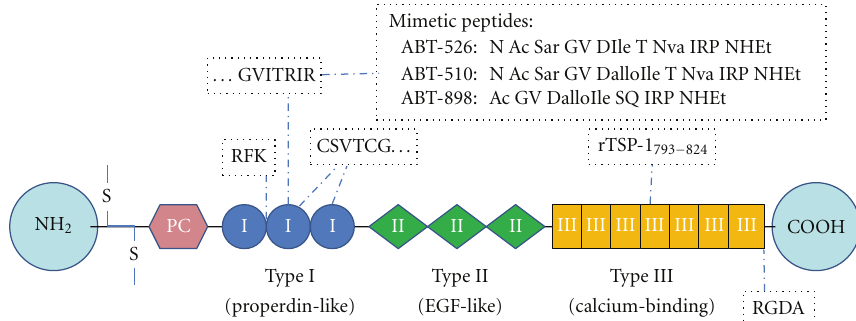
Figure 1: Schematic representation of the structure of TSP-1 and its receptor sites. TSP-1 is a large, homotrimeric molecule (420kDa). Each monomer consists of an interchain disulfide bond (S = S), procollagen homology domain (PC), Type I, II, and III repeats. The amino and carboxyl terminals are globular [8]. RFK and RGDA are the binding sites for TGF β and the integrins, respectively. CSVTCG is the receptor site for CD36. The C-terminal domain of TSP-1 binds CD47. TSP-1 mimetic peptides have been designed from the heptapeptide GVITRIR of the second type-1 repeat. ABT-526 and ABT-510 are nonapeptides and enantiomers of each other, where D-Ile was replaced with D-allo- Ile in ABT-510 [33]. Sar, Nva, and NHEt are abbreviations for sarcosine, norvaline, and ethylamide. A second generation mimetic peptide, ABT-898, has been reported to have increased potency and slower clearance [95]. These peptides have been used in clinical studies for their antiangiogenic properties. Recombinant fragment rTSP1 793–824 has been studied in experimental erosive arthritis